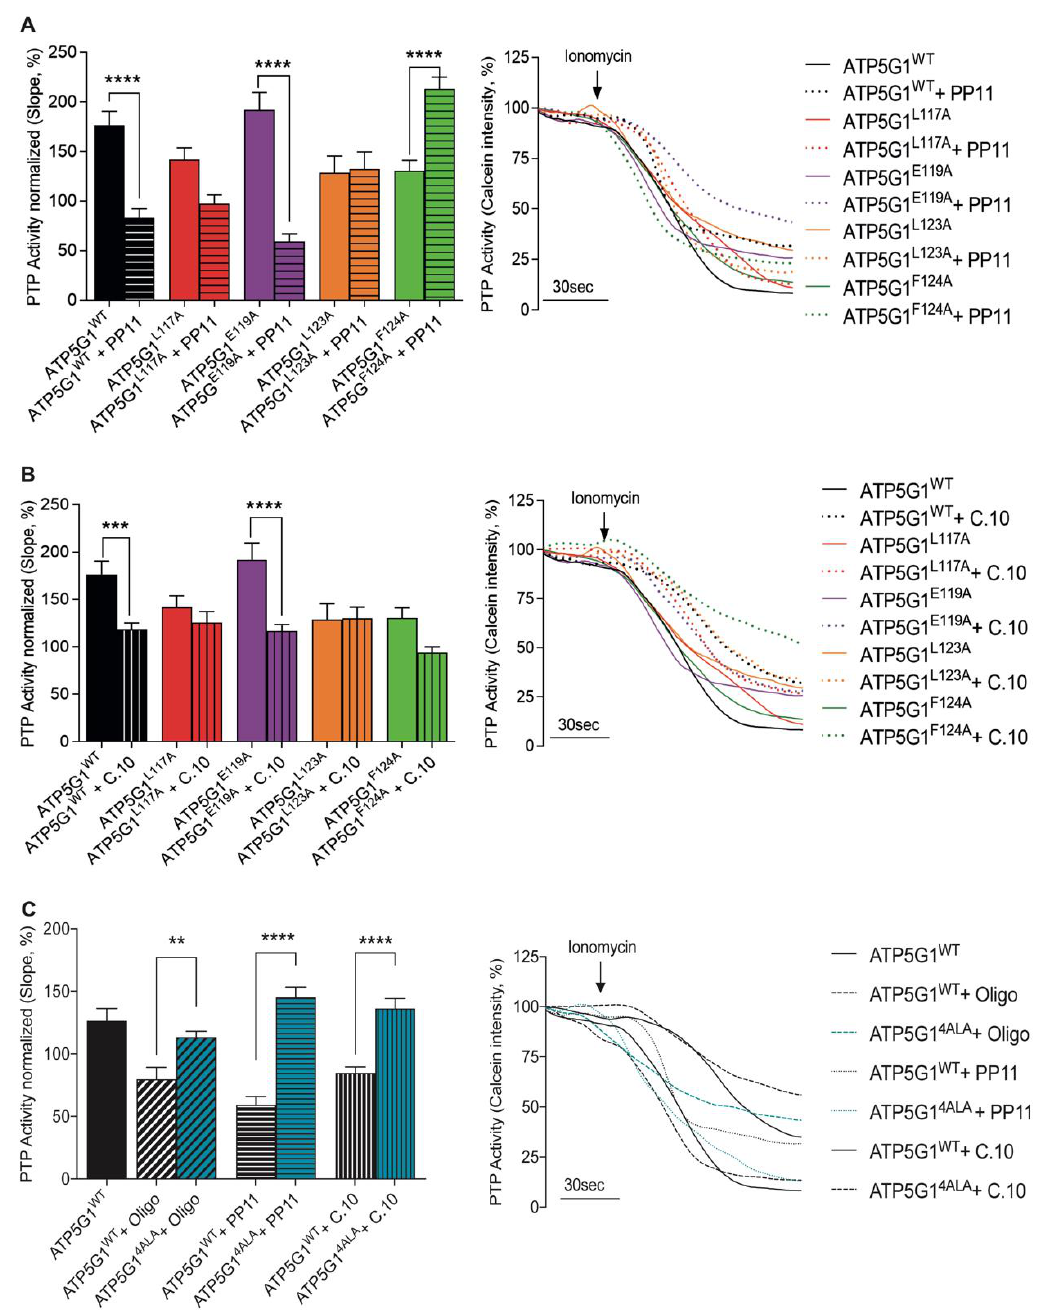
Figure 3. Differential binding of small-molecule inhibitors to Csub variants with mutated residues. ( A ) PTP activity measurement in cells overexpressing Csub variants with PP11 pre-treatment (5 µ M, 15 min). On the left, PTP activity; on the right, representative traces of PTP activity. ( B ) PTP activity measurement under conditions of mutants’ overexpression with C.10 pre-treatment (5 µ M, 15 min). On the left, PTP activity; on the right, representative traces of PTP activity. ( C ) PTP activity measurement under conditions of ATP5G1 4ALA mutant overexpression pre-treated with Oligomycin A, PP11 and C.10 and compared with ATP5G1 WT . On the left, PTP activity; on the right, representative traces of PTP activity. Graphs show mean ± SEM. Statistical differences were analyzed using one-way ANOVA: **** p < 0.0001, *** p < 0.001, ** p < 0.01.